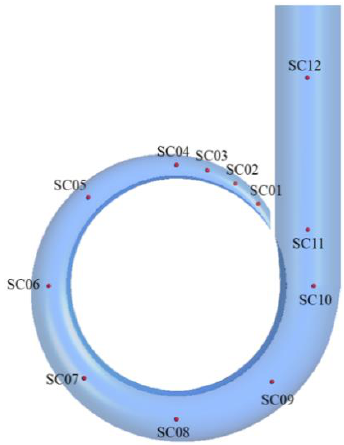
Figure 6. Monitoring points in the stay guide vanes.